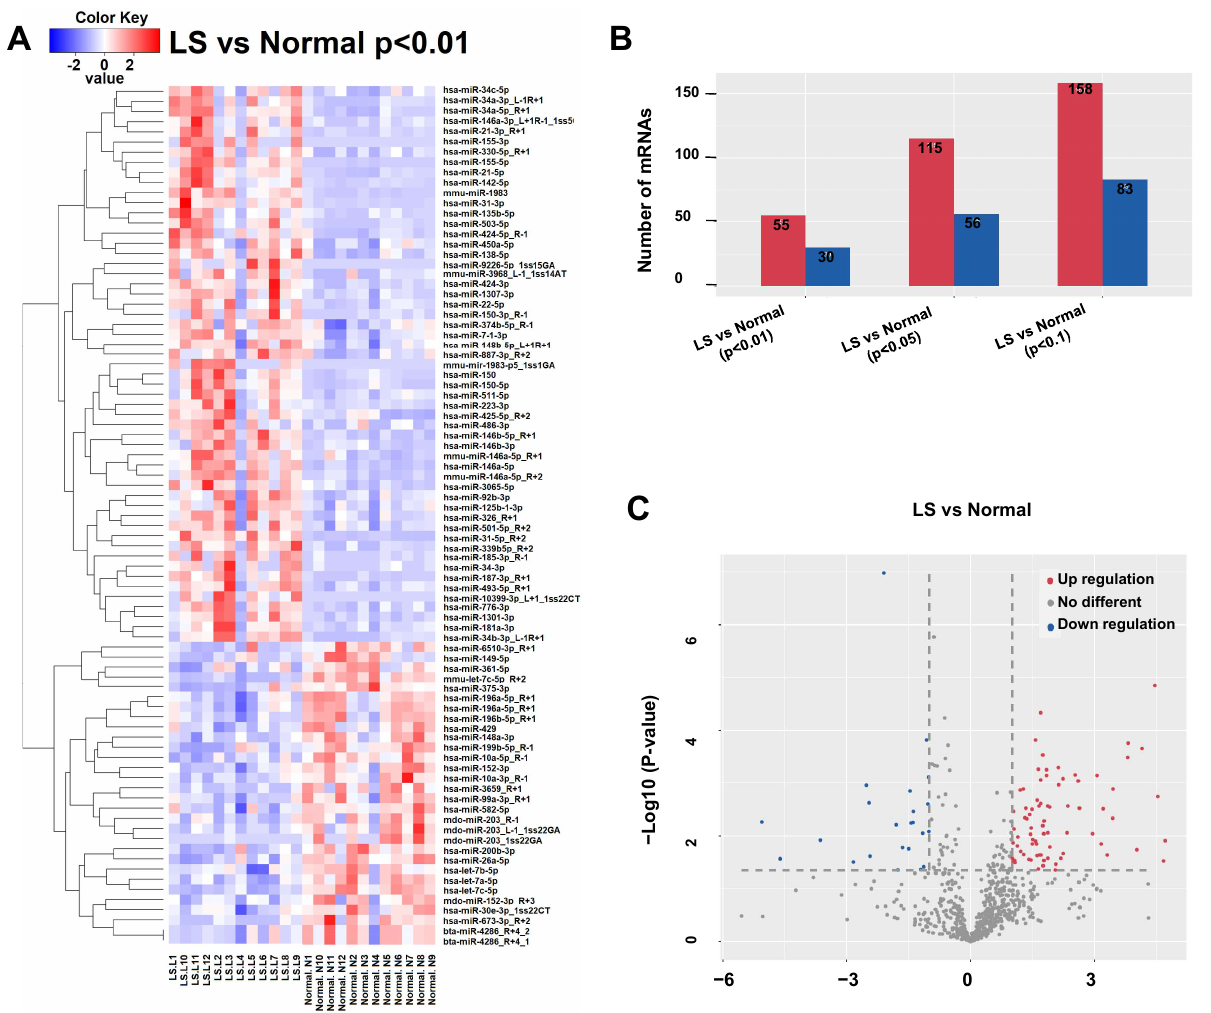
Figure 1. Differentially expressed microRNAs in LS tissue. Red signal, high relative expression; blue signal, low relative expression. ( A ) Clustering analysis of differentially expressed miRNAs between LS and matched adjacent normal tissue. The inclusion criteria were a 2-fold-change in either direction with a p -value < 0.01. ( B ) The numbers of differentially expressed miRNAs with 2-fold change under different p values (0.01, 0.05 and 0.10). ( C ) The volcano plot revealed more upregulated miRNAs than downregulated ones in LS. The inclusion criteria were a 2-fold-change in either direction with a p -value <